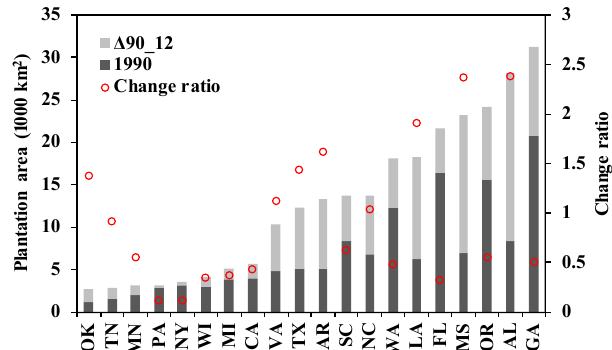
Figure 10. Plantation area in 1990 (dark gray), area change from 1990 to 2012 (light gray), and change ratio ( (cid:49) 90_12 / 1990; red circle) for the selected top 20 states with the largest plantation area in the